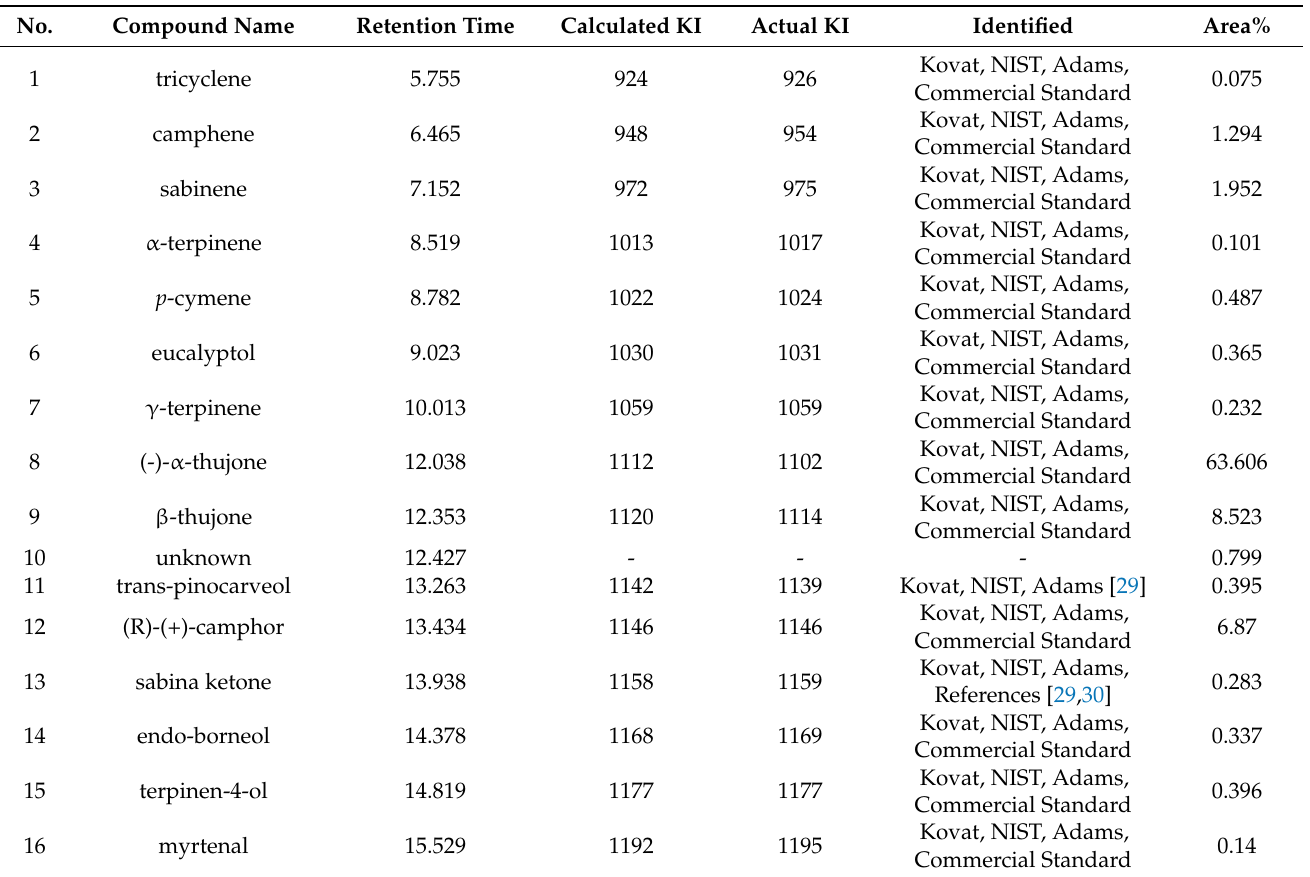
Table 3. A. herba-alba EO constituents determined via GC — MS — FID analysis.